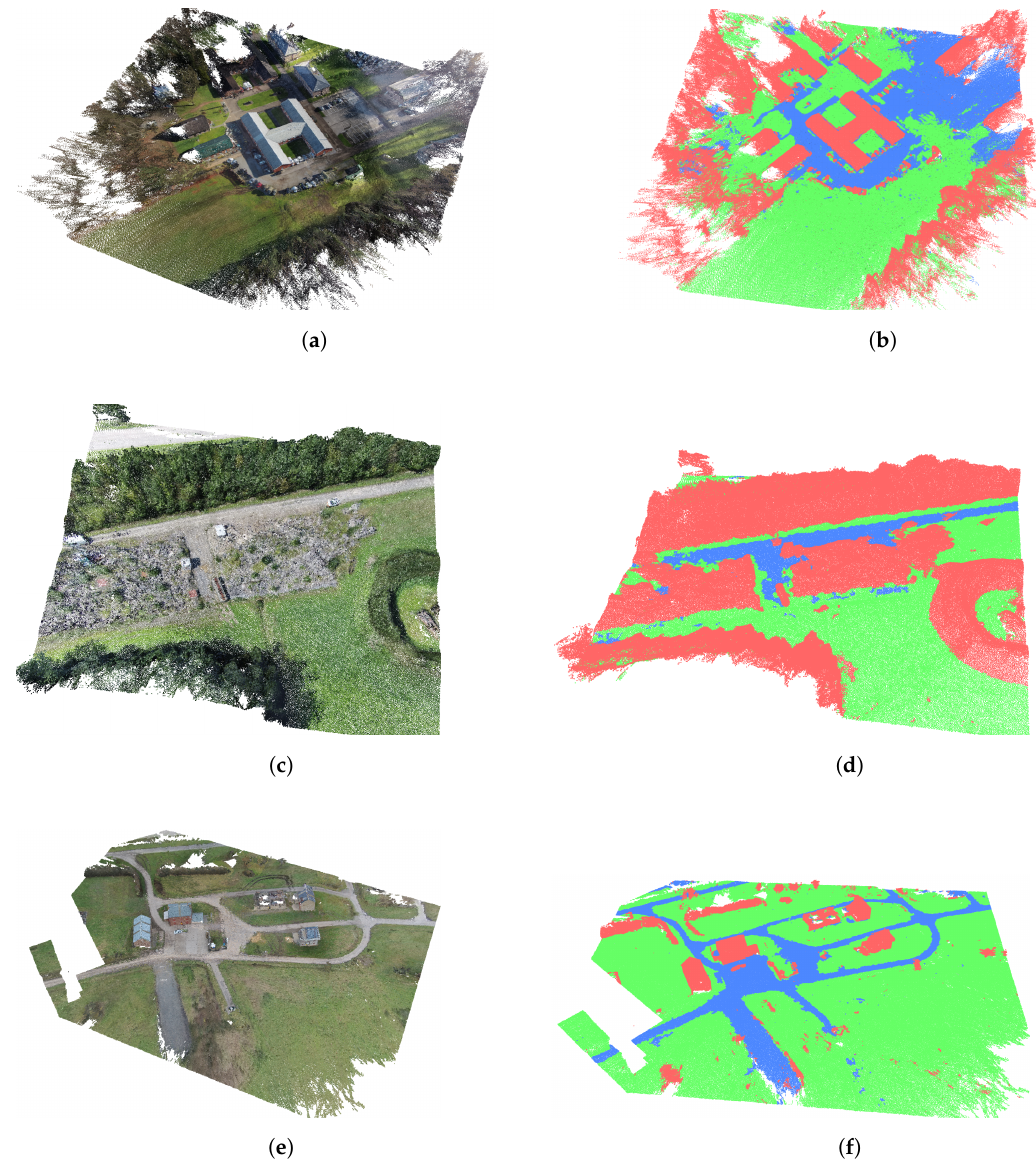
Figure 19. Outputs of the color based region growing segmentation algorithm, blue points represent the roads while the green points represent the grass and field area. The red points are the obstacles. The different scenarios are represented as follows: Dovo ( a , b ), Rubble ( c , d ), and Village ( e , f